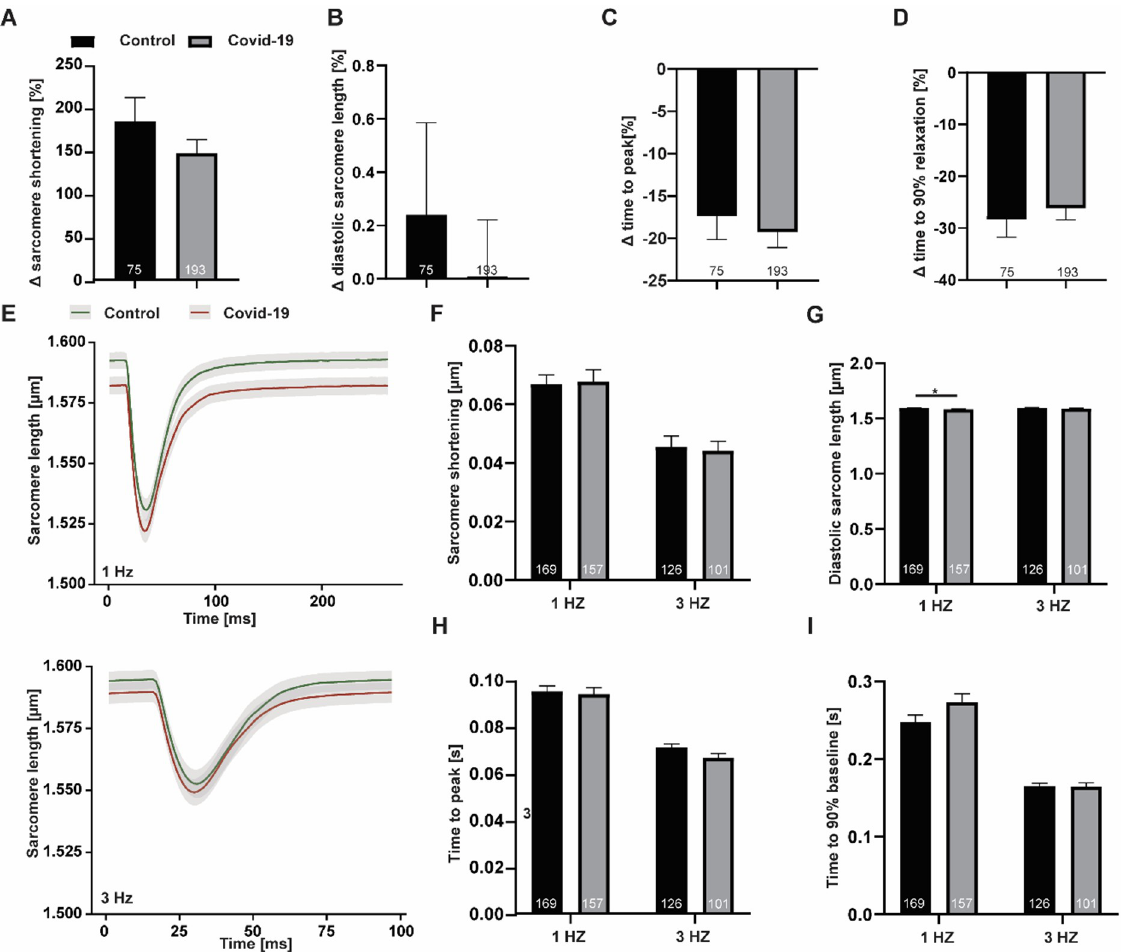
Fig 1. Excitation-contraction coupling in rat cardiomyocytes after 15 (A-D) and 60 (E-I) minutes incubation in either control (black) or COVID19 (grey) plasma, respectively. (A-D) Depicted as change after incubation in percent of initial value. (A) relative sarcomere shortening amplitude. (B) diastolic sarcomere length, (C) time to peak of sarcomere shortening and (D) time to 90% of relaxation. (E) Sarcomere shortening averaged over all cells per group at 1 Hz (upper) and 3 Hz (lower) electric stimulation and 1 mM extracellular [Ca2+]. Related data of (F) sarcomere shortening amplitude, (G) diastolic sarcomere length, (H) time to sarcomere shortening peak and (I) time to 90% sarcomere relaxation. � p <